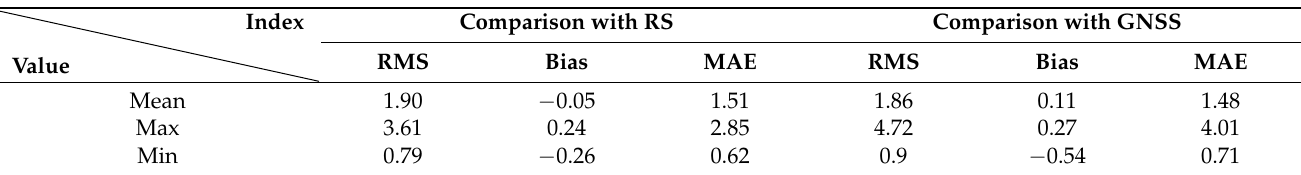
Figure 5. Time series of hourly PWV derived from ERA5 and RS at two stations and PWV difference statistics over the period from 2012 to 2020. Table 3. Statistical results of RMS, Bias, MAE of PWV differences between ERA5 and GNSS (260)/RS (87) in China over the period of